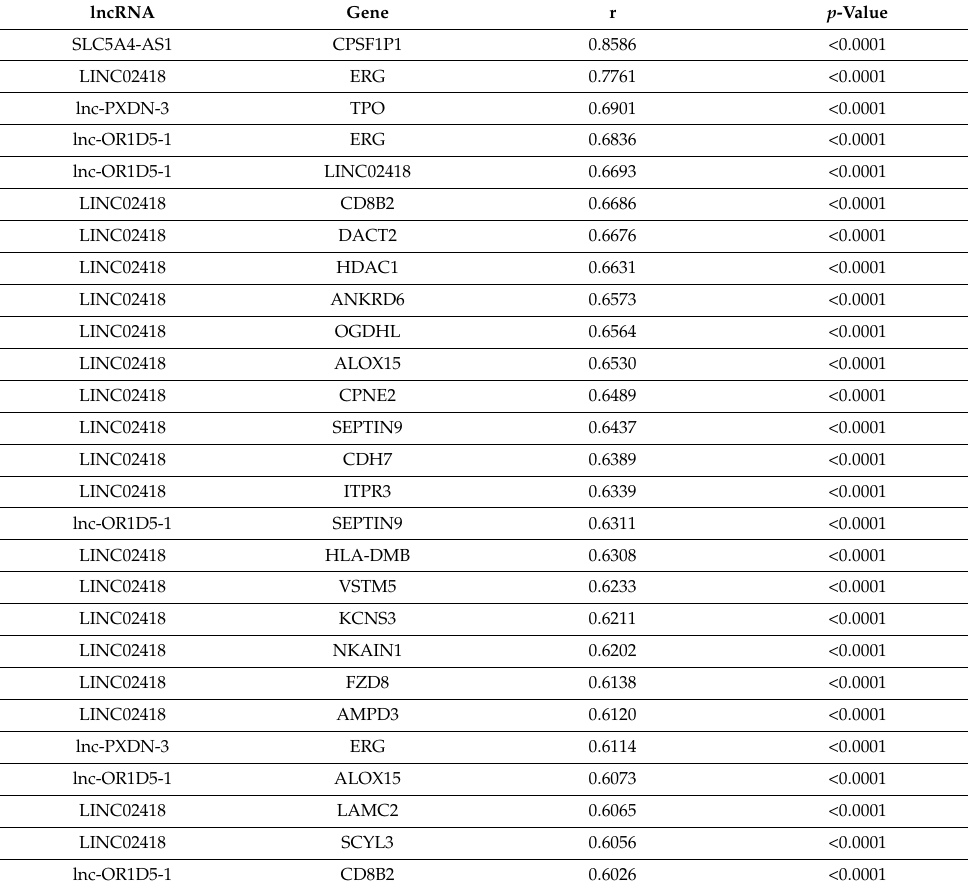
Table 2. Co-expressed long non-coding RNAs(lncRNAs) and coding genes.